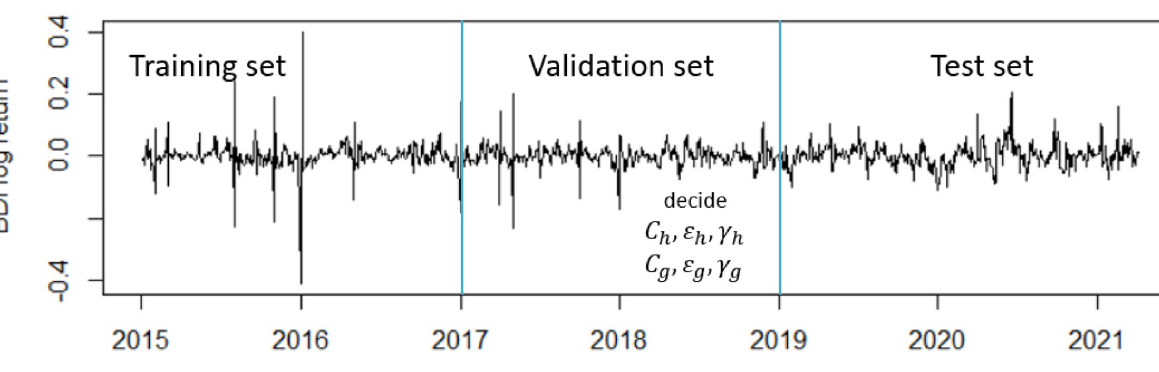
Fig 11. Log return of BDI.